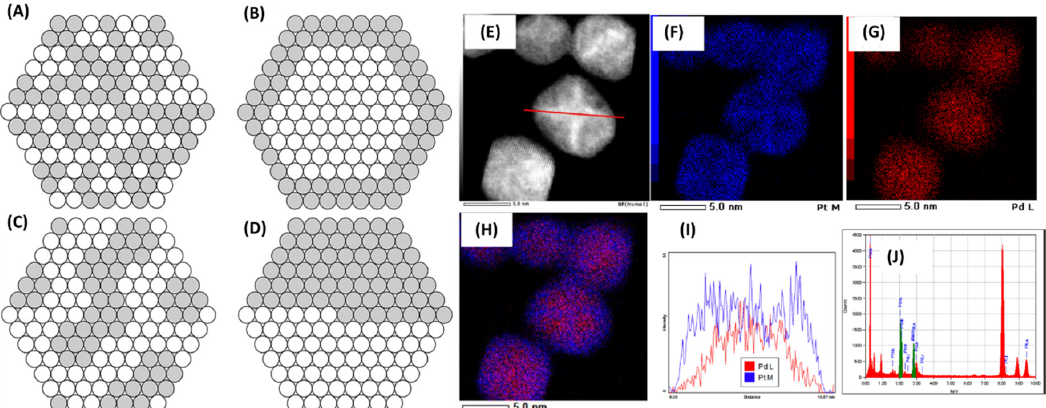
Figure 27. Schematic model of ( A ) random, ( B ) core-shell, ( C ) cluster-in-cluster, and ( D ) separated model for a six layered nanoparticle comprising of 923 atoms; HAADF-STEM image is shown in ( E ), Pt-M, and Pd-L edge spectra are shown in ( F ) and ( G ) respectively, ( H ) shows the overlay of these two, EDS line profile diagonal to a particle denoted in ( E ) is shown in ( I ), ( J ) shows EDS spectra of Pd/Pt (1/1) prepared using single-mode batch type µwH method in EG. Adapted with permission from the American Chemical Society. Copyright 2018 American Chemical Society.